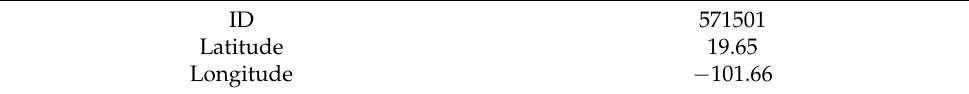
Table 1. Station